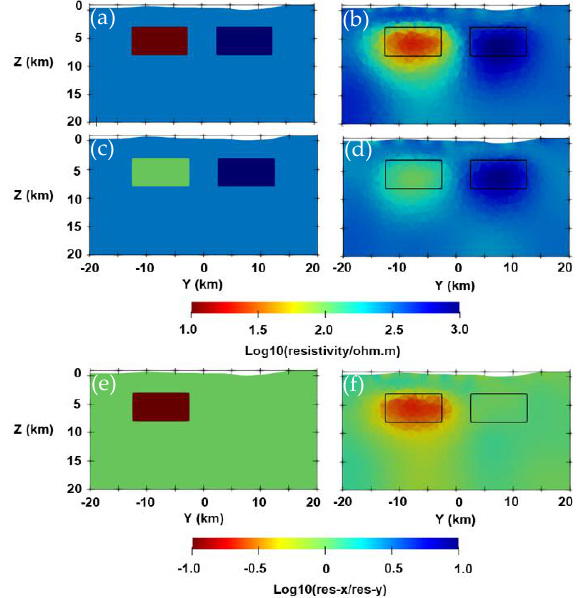
Figure 19. Convergence plot for the isotropic and anisotropic blocks model with topography. The black dashed line indicates the threshold RMS.